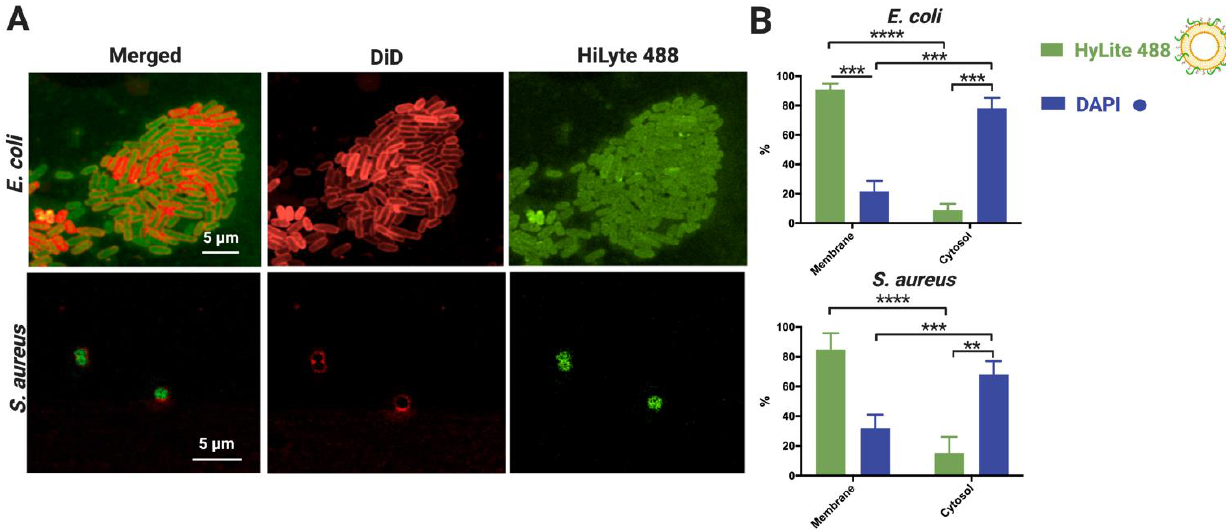
Figure 4. Assessment of HiLyte 488 labeled NAM-ONs internalization by post-PEGylated lipoplexes in HEPES buffer, upon 1 h incubation. ( A ) Representative CLSM images of E. coli ( top ) and S. aureus ( bottom ) showing NAM-ONs (green fluorescence) internalized in the cytosol. Bacterial membranes were labeled with DiD dye (red fluorescence). Merged and separate channels are represented. Scale bar represents 5 µ m. ( B ) Percentage (%) of NAM-ONs localized in the cytosol and in the membrane, calculated using Equation (4). A DAPI control of cytosol labeling was performed. Three independent experiments were done. Results are represented as mean values and respective standard deviations. Statistical differences are indicated when appropriate ( p ≤ 0.0001, **** ; p ≤ 0.001, *** ; and p ≤ 0.01, ** ).